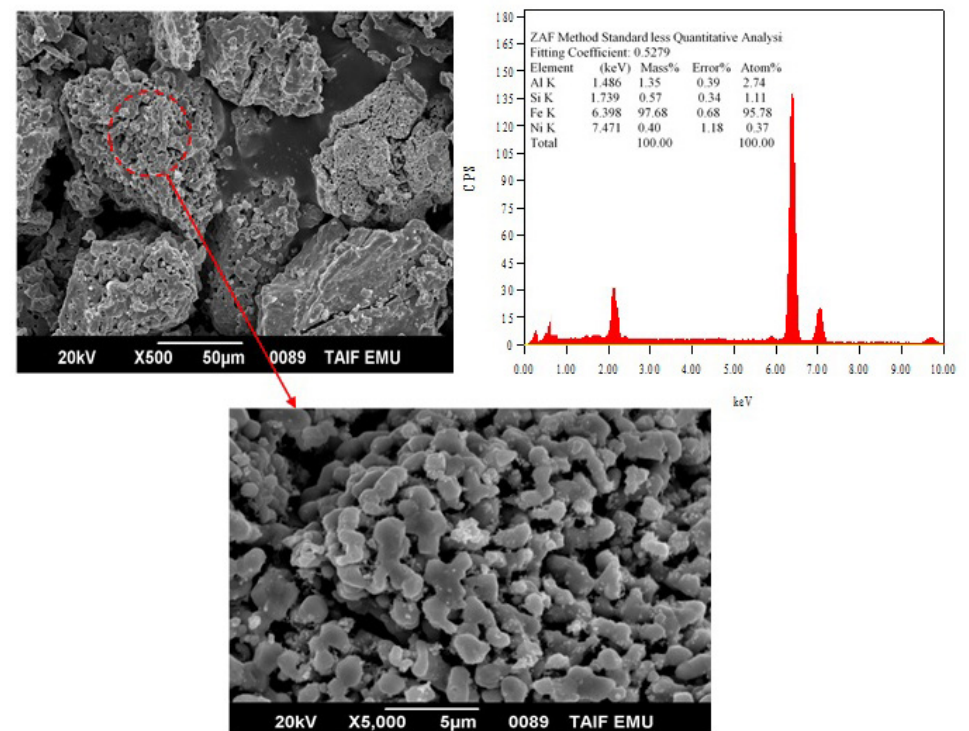
Figure 6. SEM image and correspondent “EDS” spectrum analysis of reduced iron powder at 800 0 C in H